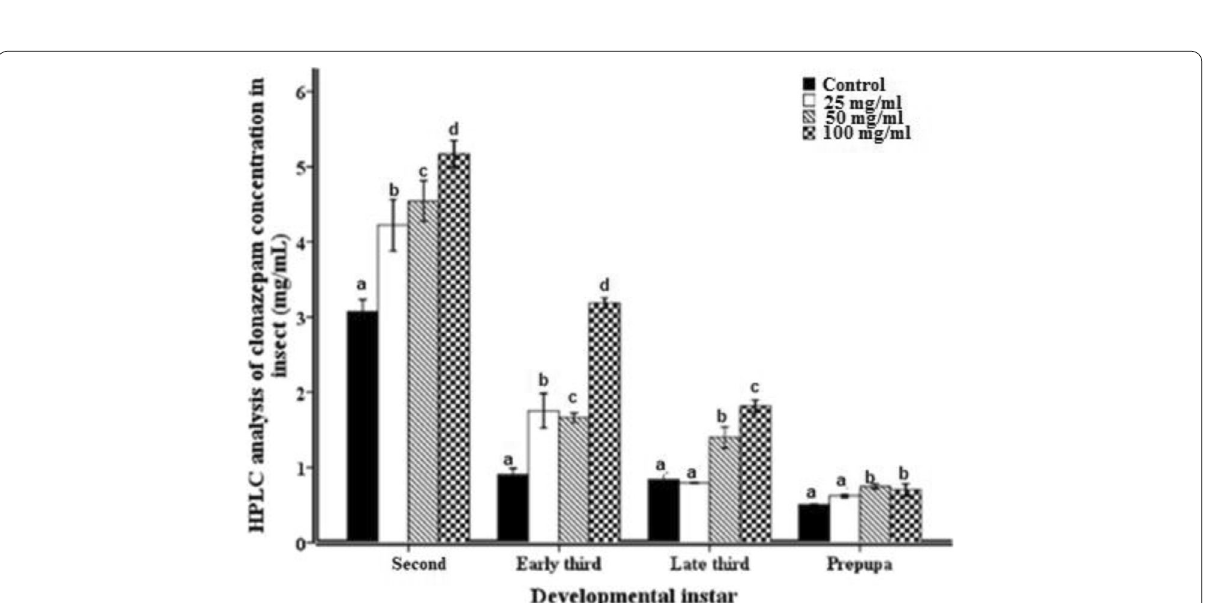
Fig. 2 Detection of clonazepam concentration in larval and prepupal tissues of Sarcophaga argyrostoma , which fed on different concentrations of clonazepam (25, 50, or 100 mg/ml), using HPLC. Data expressed as median and standard deviation (SD). Median values marked with different small letters were significantly different ( p < 0.05) regarding to clonazepam